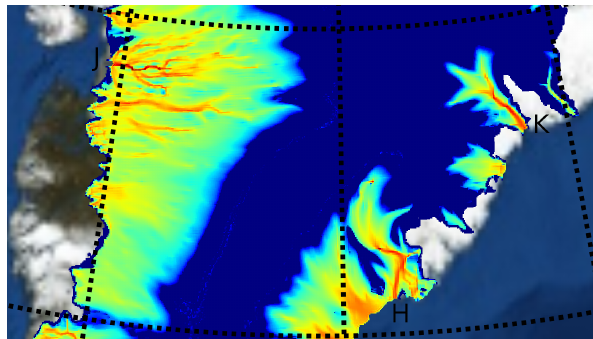
Figure 8. Detail of transportable water W plotted in Fig. 7, cover- ing Jakobshavn (J), Helheim (H), and Kangerdlugssuaq (K) outlet